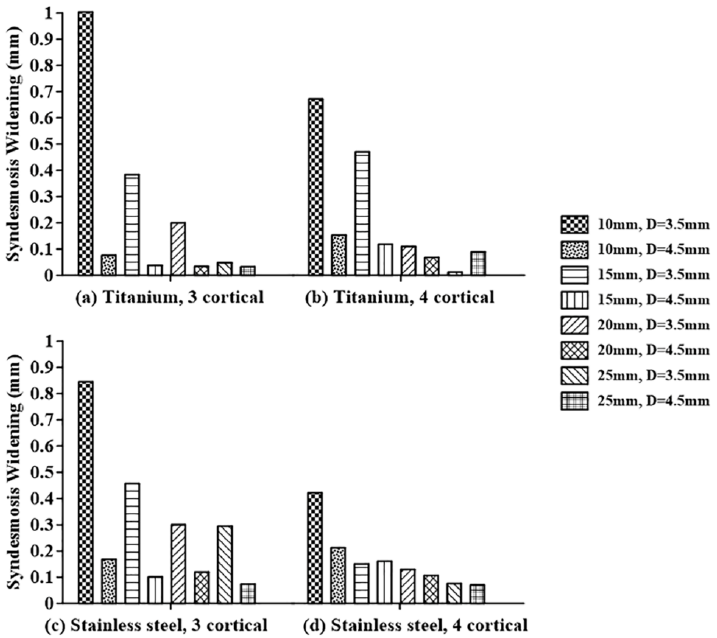
Figure 13. Analysis of the syndesmosis widening in terms of the screw diameter for: ( a ) titanium screw penetrating into three cortical bones, ( b ) titanium screw penetrating into four cortical bones, ( c ) stainless steel screw penetrating into three cortical bones, and ( d ) stainless steel screw penetrating into four cortical bones.